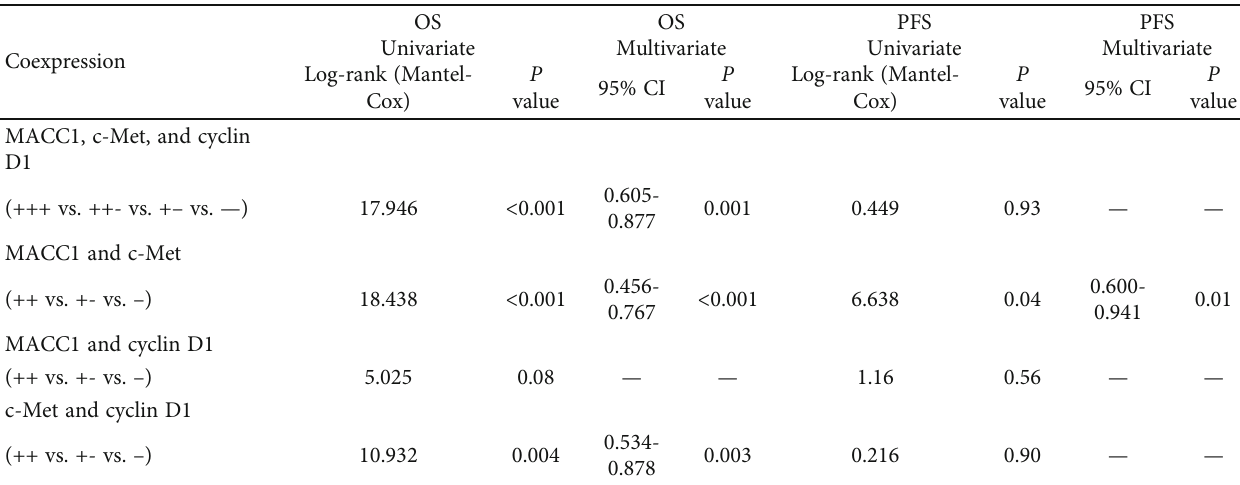
Table 8: E ff ects of coexpression of MACC1, c-Met, and cyclin D1 on the prognosis of